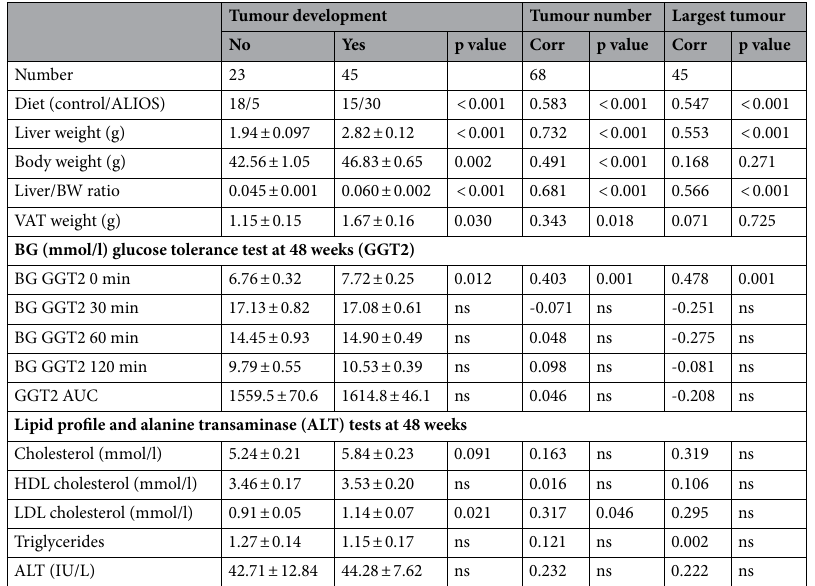
Table 1. Gross phenotype features associated with tumours. Means ± standard errors are shown for continuous data. Differences between continuous non-parametric were assessed with Mann–Whitney Tests. Key: BW—body weight; BG—blood glucose; GGT—glucose tolerance test; AUC—area under curve; HDL— high density lipoprotein; LDL—low density lipoprotein. Pilot and follow up study, 48 weeks, n =